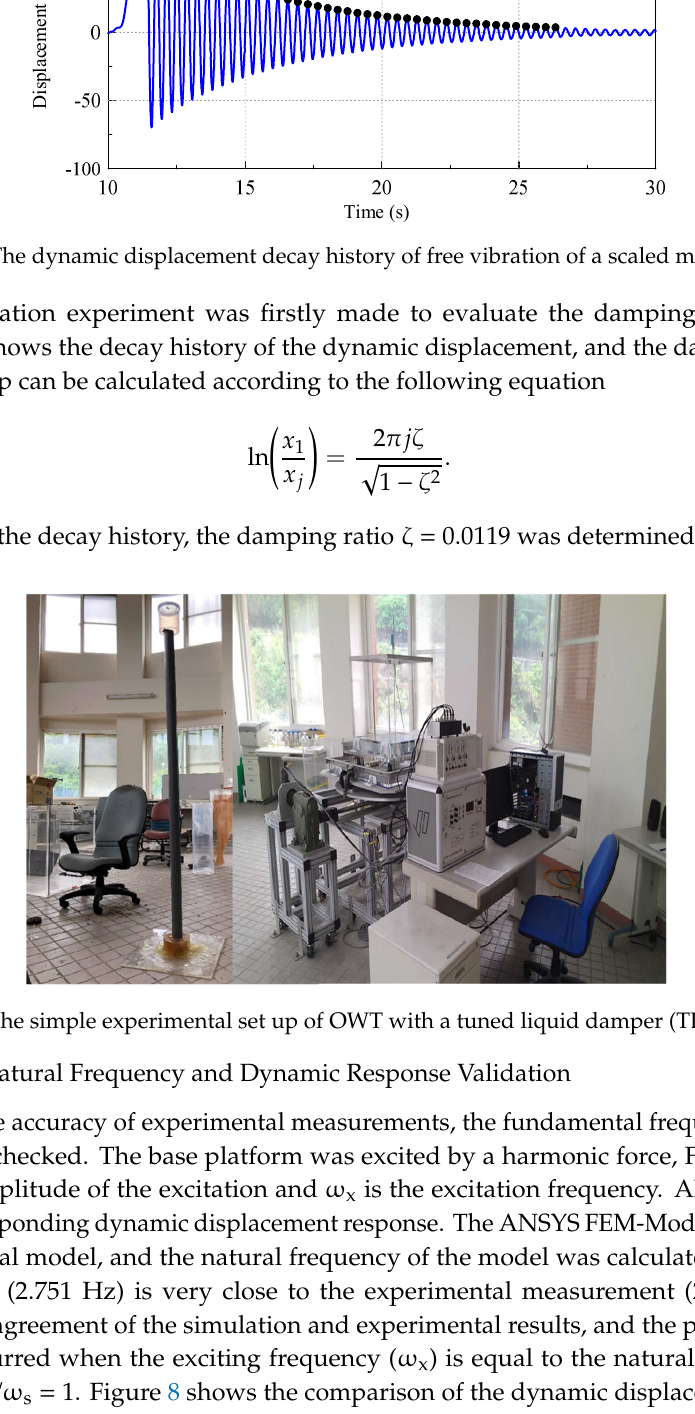
Figure 6. The dynamic displacement decay history of free vibration of a scaled model OWT.